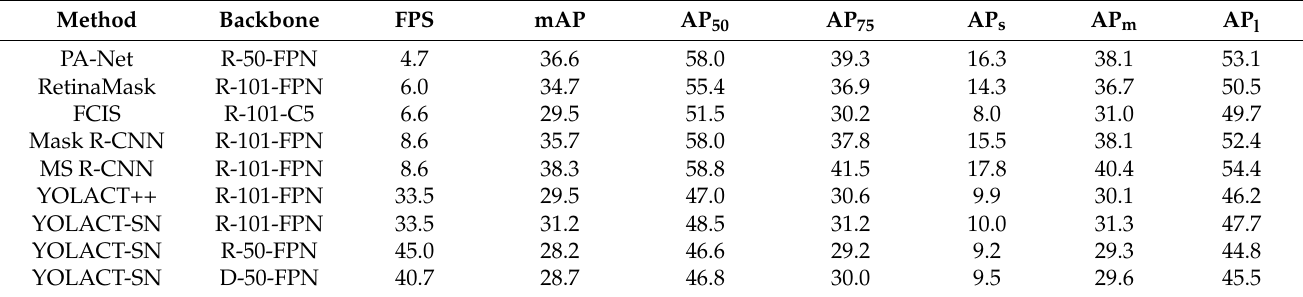
Table 1. Comparison of experimental results of different instance segmentation algorithms.